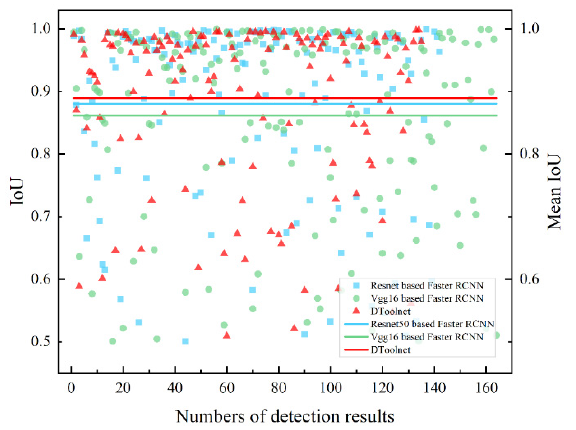
Figure 14. Comparison of IoU of different networks.